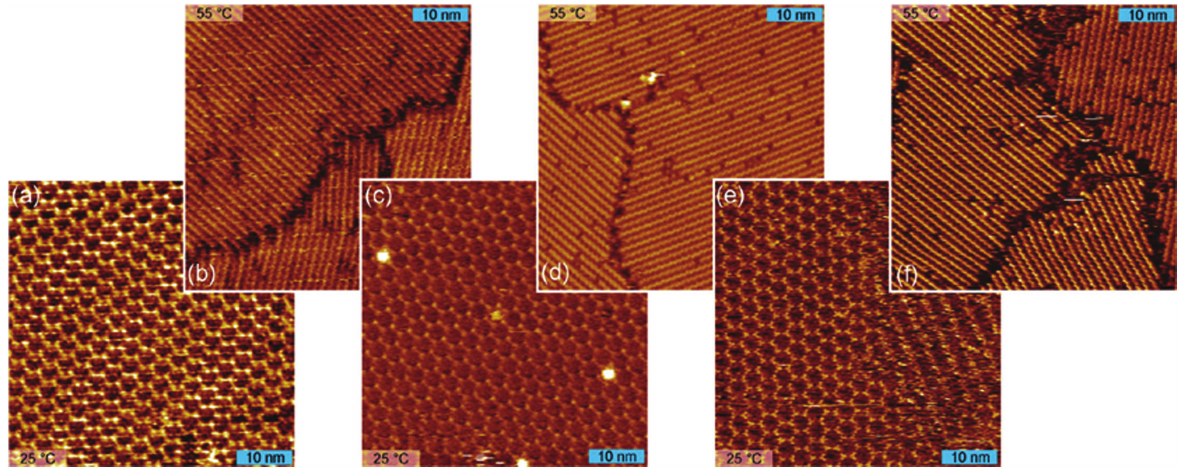
Figure 3 Reversibility of the phase transition visualized via STM topographs during repeated heating-cooling cycles of saturated BTB in nonanoic acid (scale bar, 10 nm, reprinted with permission from [29]). Copyright 2010, American Chemical